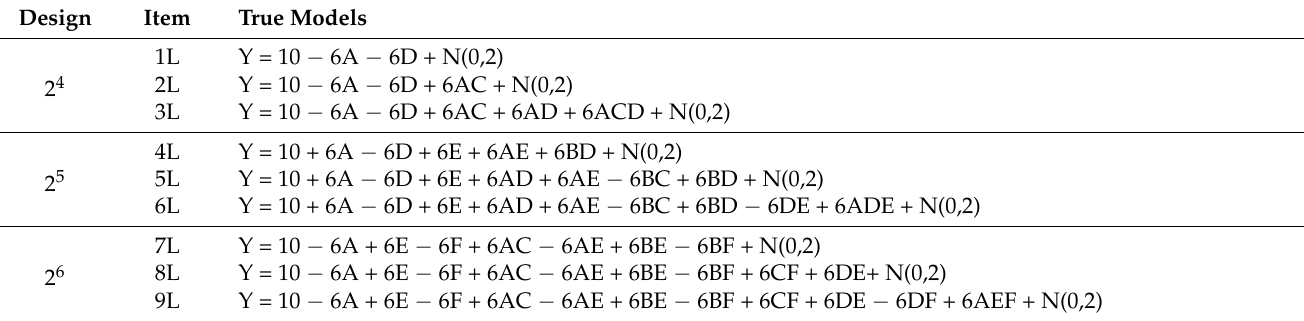
Table 3. True models with low